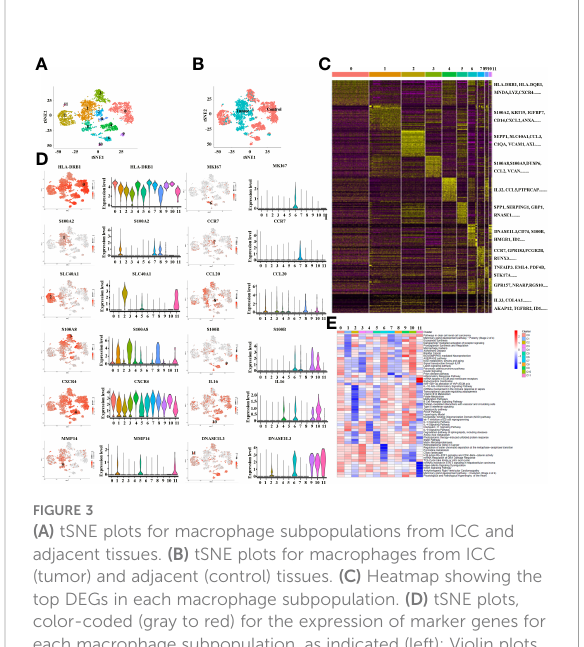
FIGURE 3 (A) tSNE plots for macrophage subpopulations from ICC and adjacent tissues. (B) tSNE plots for macrophages from ICC (tumor) and adjacent (control) tissues. (C) Heatmap showing the top DEGs in each macrophage subpopulation. (D) tSNE plots, color-coded (gray to red) for the expression of marker genes for each macrophage subpopulation, as indicated (left); Violin plots of marker genes for each macrophage subpopulation, as indicated (right); (E) Differences in pathway activity (scored per cell by GSVA) in 12 macrophage cell subclusters in tumor and control